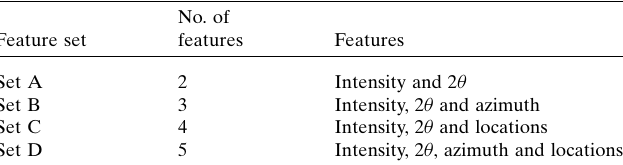
Table 2 Sets of features used for ML